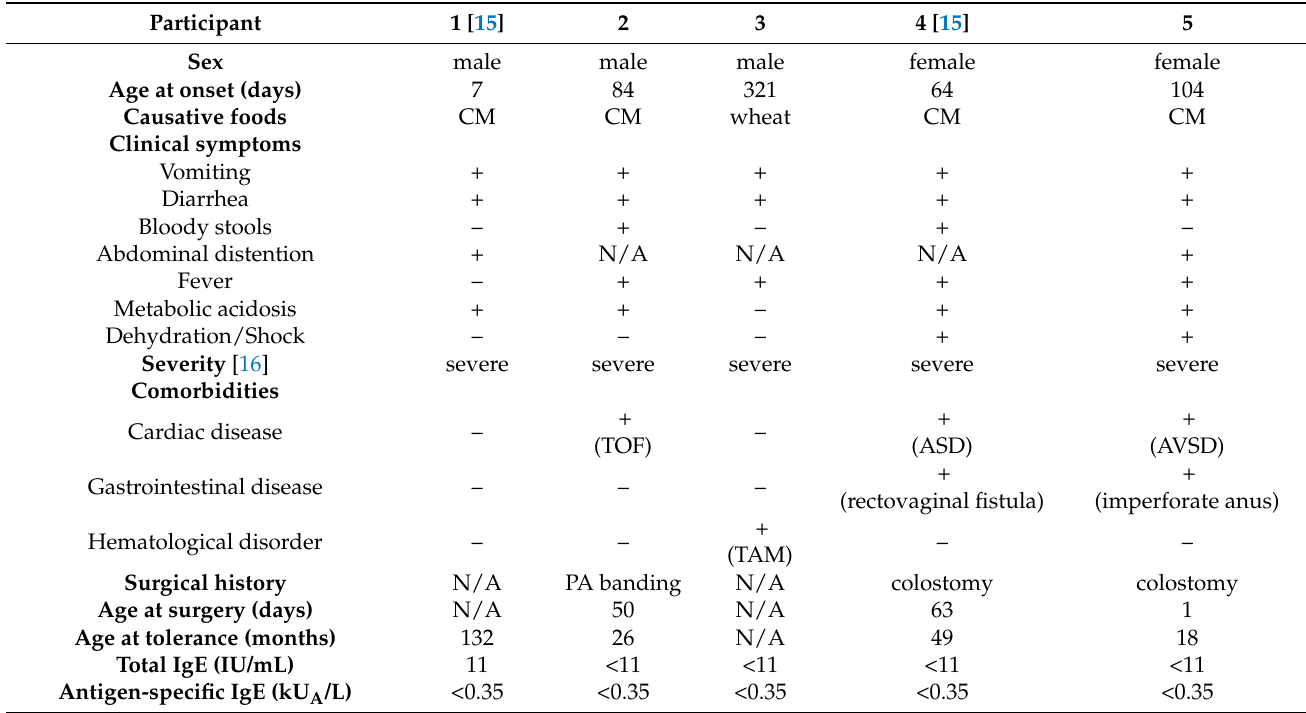
Table 4. Clinical features of FPIES in children with